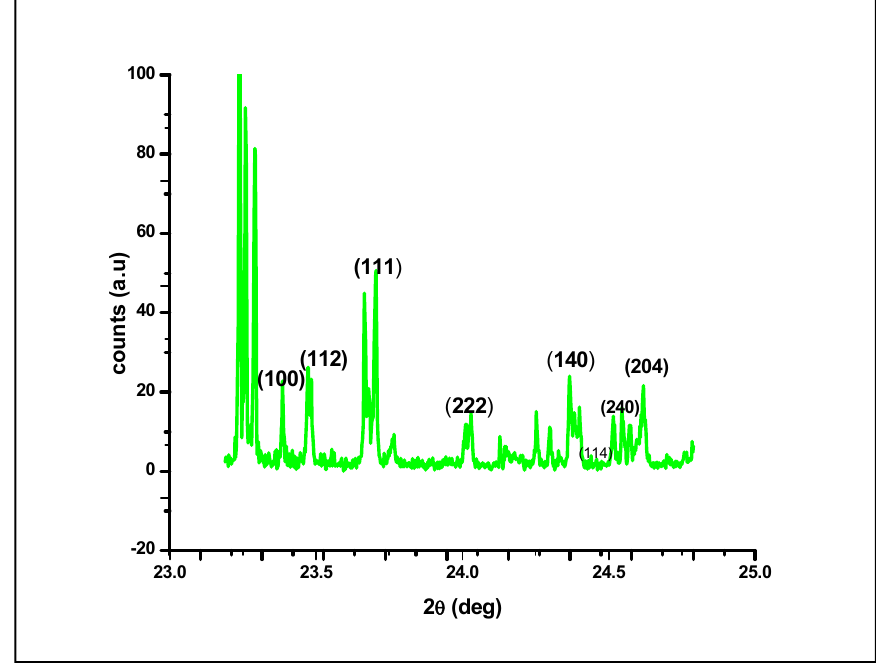
Figure 5. X–ray diffraction analysis of silver nanoparticles (AgNPs) synthesized by the aqueous extracts of G. sessiliforme .